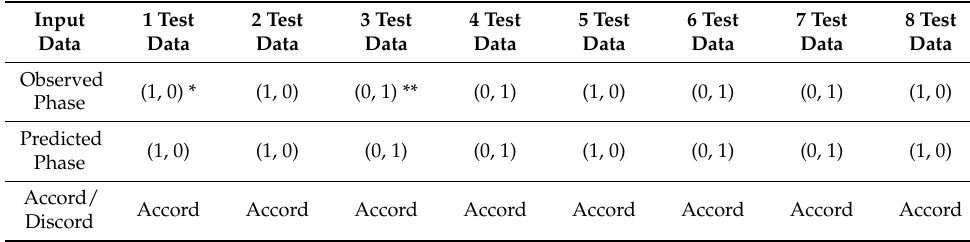
Table 3. The prediction results of high-entropy alloy